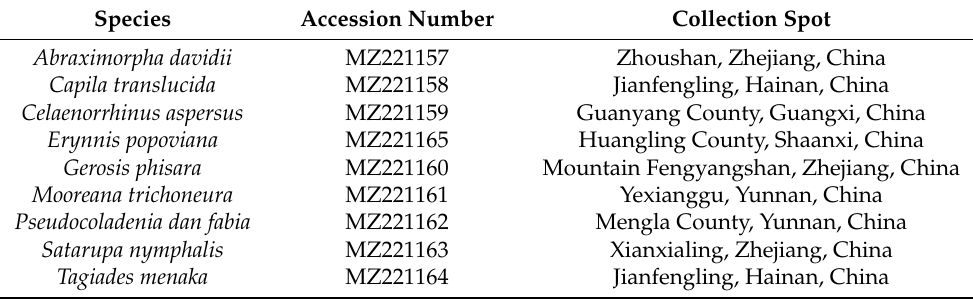
Table 1. Species information and GenBank accession